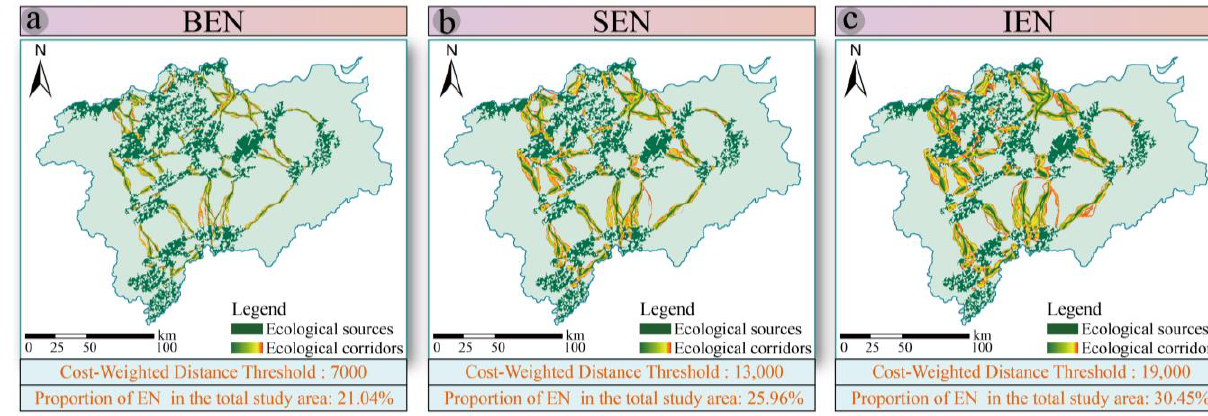
Figure 5. Three types of ENs.